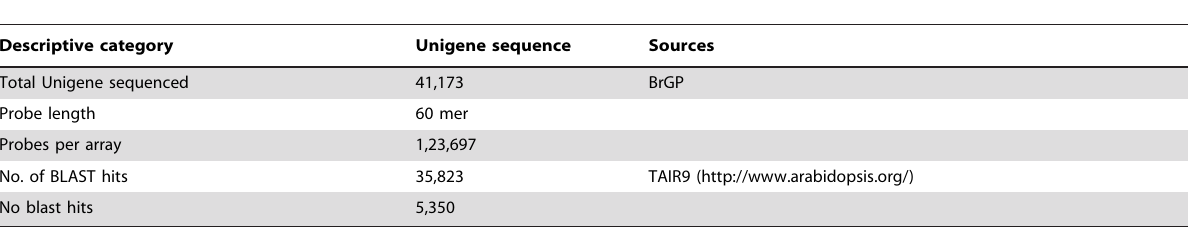
Table 1. General clustering of B. rapa unigene